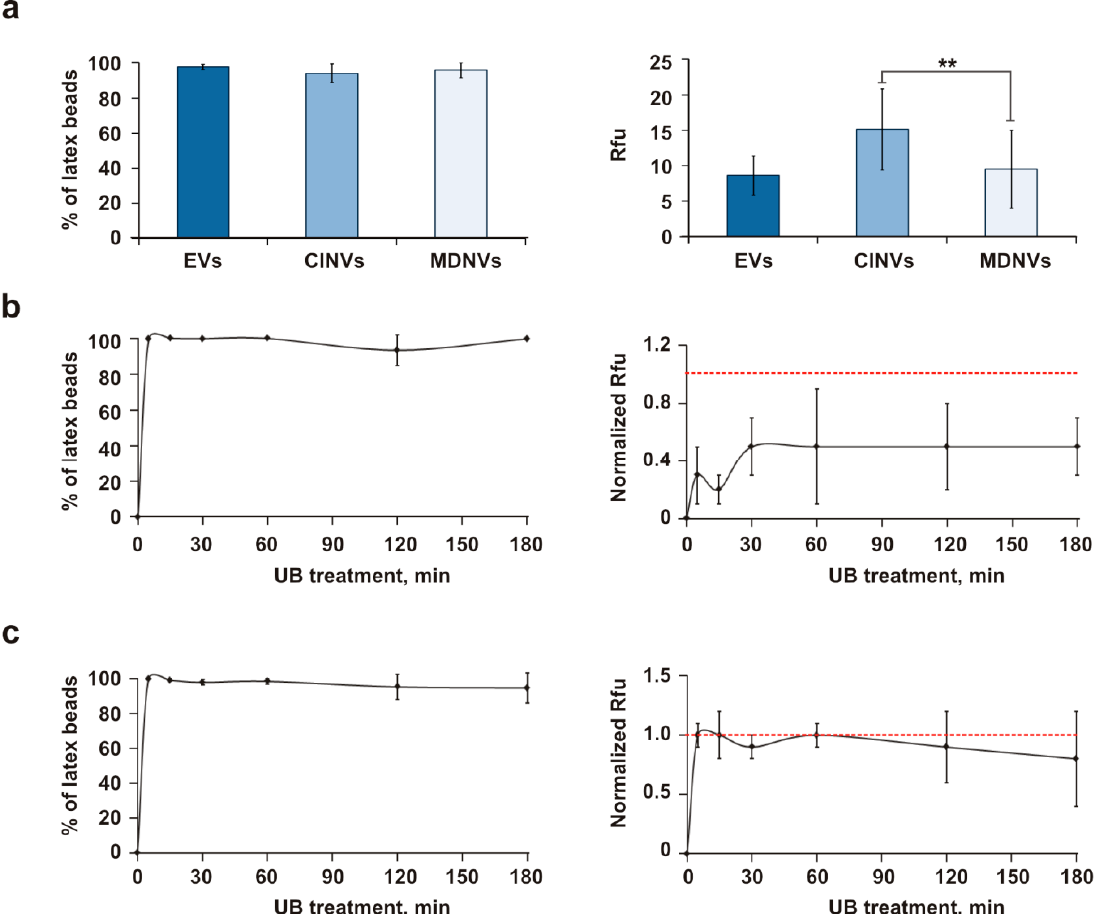
Figure 3. Loading of CINVs and MDNVs with FAM-ON. ( a ) Comparison of loading EVs, CINVs, or MDNVs with FAM-ON by Fr/Th. ( b ) Generation of MDNVs by UB in solution that contained FAM-ON. ( c ) Generation of MDNVs by UB followed by loading with FAM-ON by Fr/Th. The EV–FAM-ON, CINV–FAM-ON, and MDNV–FAM-ON complexes were immobilized on 4 µm aldehyde/sulfate latex beads and analyzed by flow cytometry. To correctly compare different MDNV generation techniques, Fr/Th was chosen as a positive control, and the observed Fr/Th Rfu level was set at 1 (shown as the red, dashed line). All experiments were performed in TBS that contained 15 µg nanovesicles and 50 µM FAM-ON. Data are presented as mean ± standard deviation. Statistical analysis was performed with the Mann–Whitney test; * p ≤ 0.05, ** p < 0.05, *** p ≤ 0.01.